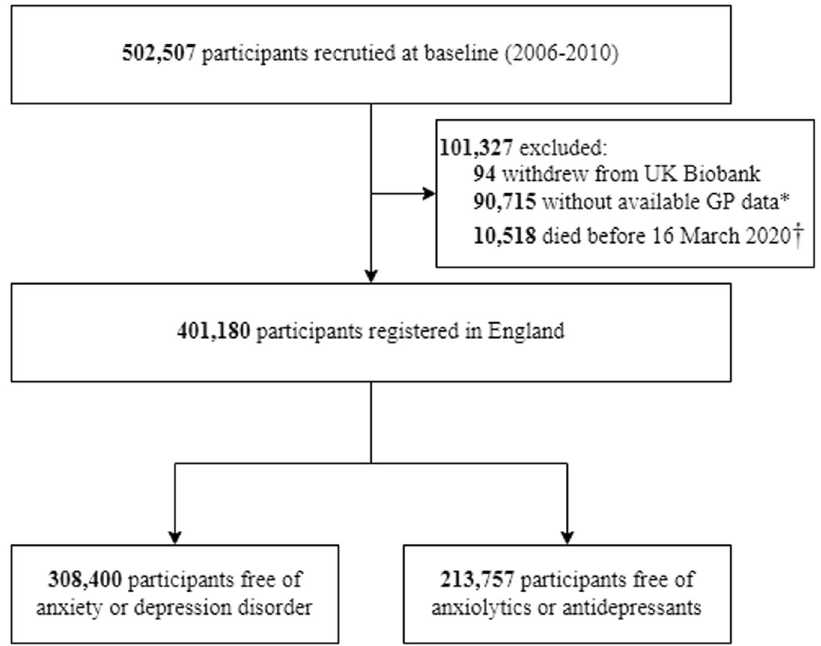
Fig. 1 Flow chart of the COVID-19 pandemic exposure population. * The primary care data were only available for participants registered in England and registered at a practice using TPP or EMIS as their data system supplier. † Considering the results of COVID-19 tests was